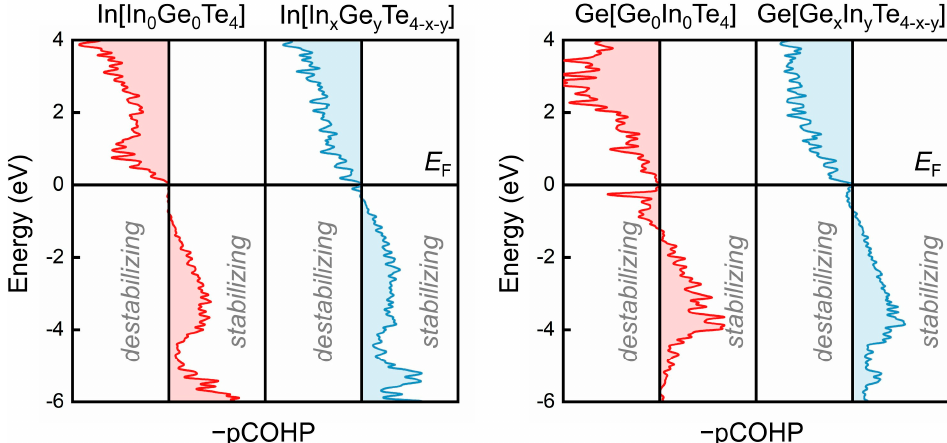
Figure 3. Projected COHP (pCOHP) for tetra-In and tetra-Ge motifs in a-InGeTe 2 . Tetrahedral motifs are classified as the ones with only heteropolar bonds, denoted as In[In 0 Ge 0 Te 4 ] and Ge[Ge 0 In 0 Te 4 ], and the others with at least one wrong bond indicated as In[In x Ge y Te 4 − x − y ] and Ge[Ge x In y Te 4 − x − y ] (x or y ≥ 1, x + y ≤ 4).